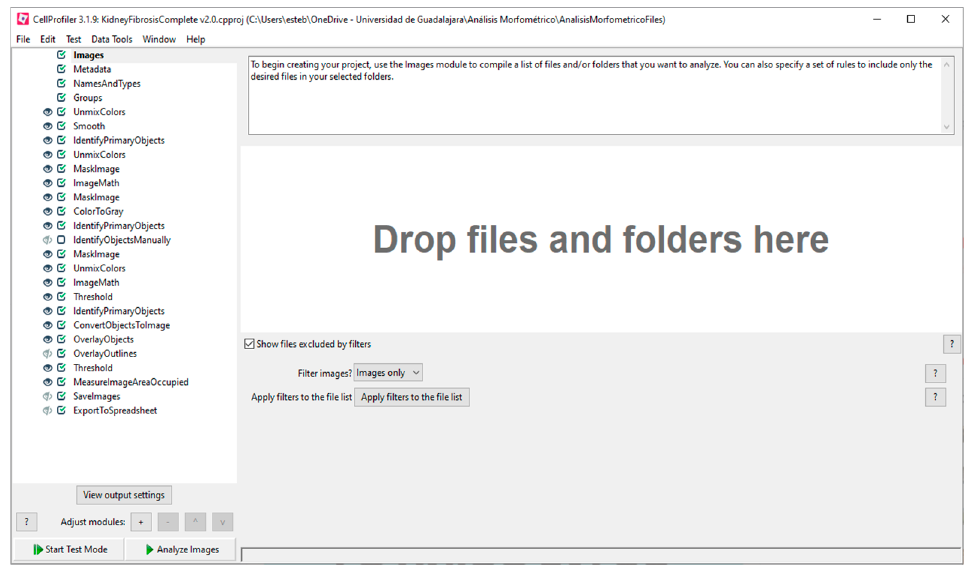
Figure 2. CellProfiler™ pipeline for the analysis of kidney fibrosis.